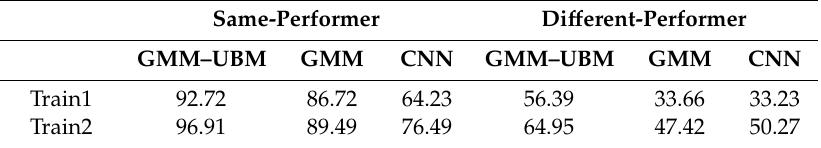
Table 11. Comparison of performance between the two performer-based